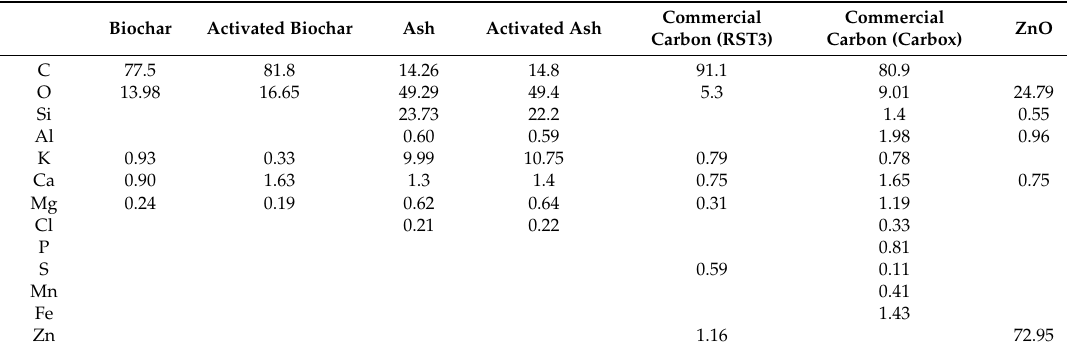
Table 1. Composition in terms of weight fraction for the materials